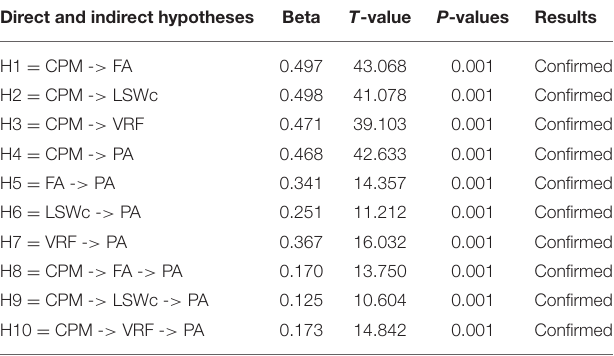
TABLE 6 | Structural results for proposed hypotheses. Direct and indirect